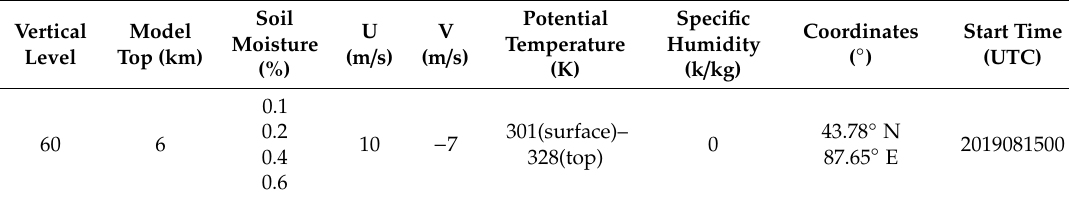
Table 1. Initial conditions of the single-column model (SCM) ideal